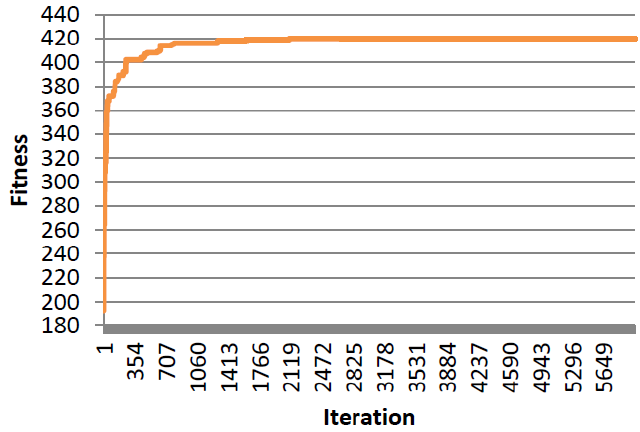
= 2, c = 2, w = 0.8, V = 1 2